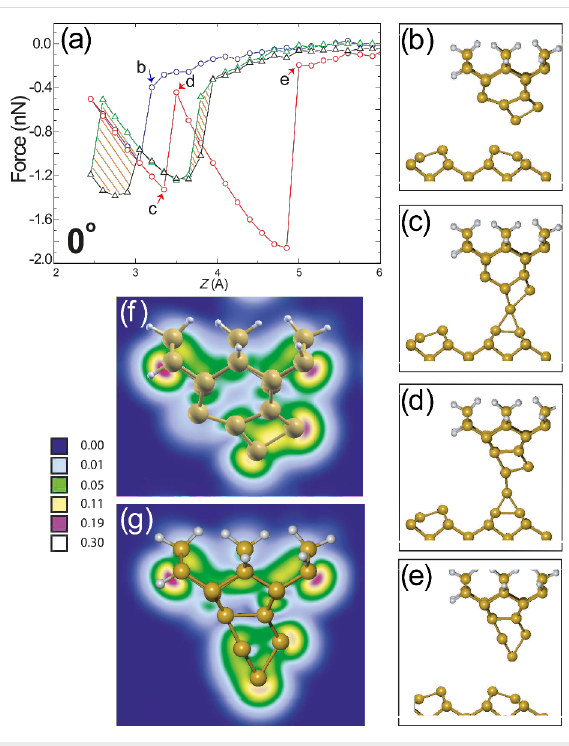
Figure 4: Structural development during tip indentation. (a) Calculated F ( z ) approach and retraction curves for the D 2 tip at “0°” positioned above down (red and blue circles) and up (green and black triangles) surface dimer atoms. Calculation with the tip positioned above the down atom leads to structural rearrangement of the tip, noticed as discontinuities in the retract curve at ≈ 3.5 Å and ≈ 5 Å. The ball-and- stick model in (b) depicts the starting configuration of the tip during the approach, which is followed by the major stages in tip rearrangement during retraction (c–e). Partial electron density plots (calculated within the range 0–1 eV below the Fermi energy and plotted on a square root scale of electrons/Bohr 3 ) of (f) initial and (g) final tip (D 2a ) configura- tions. Plots were made using the XCrySDen software [46].